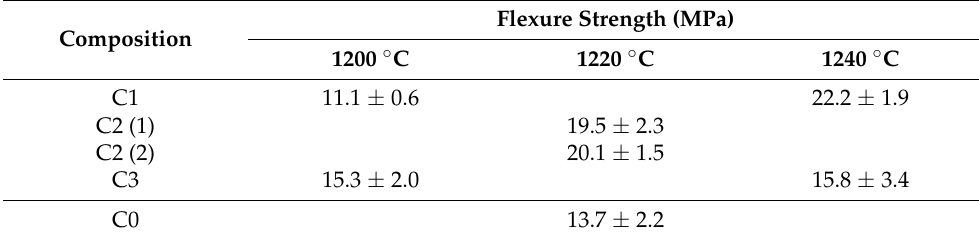
Table 10. Flexure strength of studied compositions at different firing